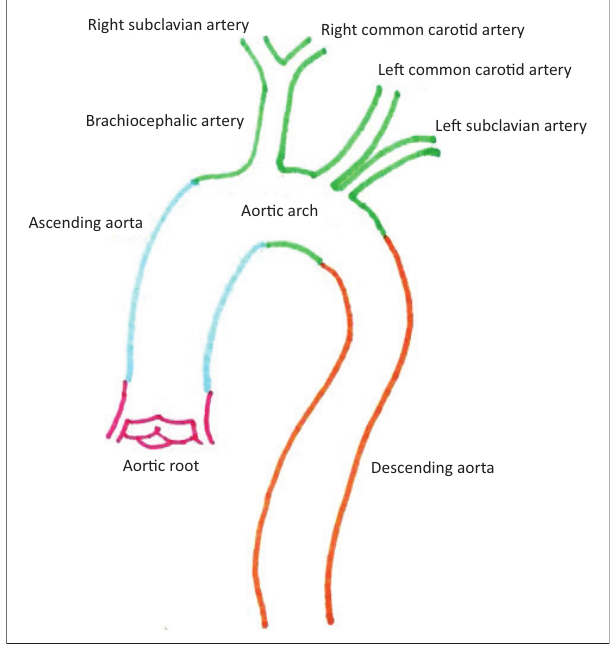
FIGURE 5: Annotated diagram of different aortic segments. Aortic root (0 in red), segment 1 in blue, segment 2 in green and segment 3 in orange. Isthmus represents the area at the orange and green